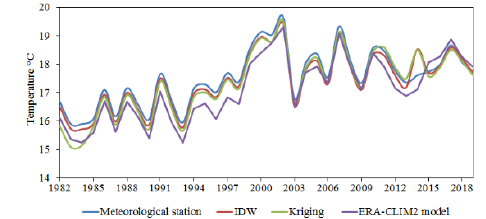
Figure 6. Spatial distribution map of summer air temperature estimated by Kriging over Mongolia.